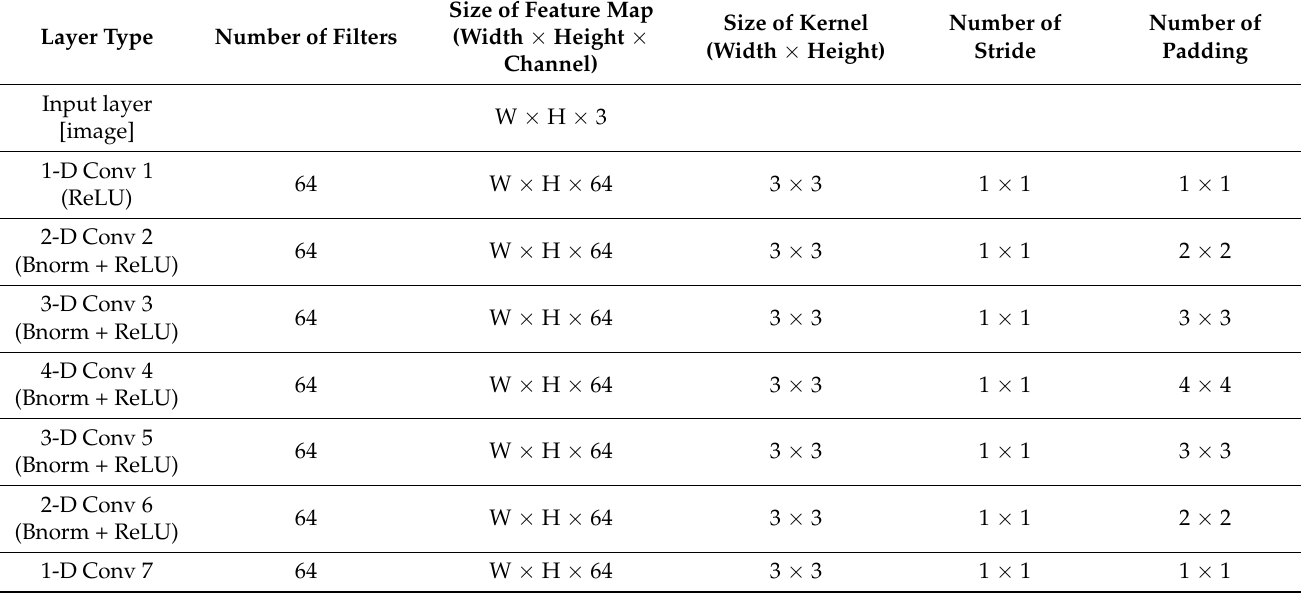
Table 2. Architecture of IRCNN. (D Conv in n-D Conv indicates a dilated convolution layer. Here, n is the dilation rate, which is the same as that applied for standard convolution when n = 1. ReLU refers to a rectified linear unit, and Bnorm refers to batch normalization. An IRCNN uses an original image with unfixed width and height; thus, W and H are denoted).